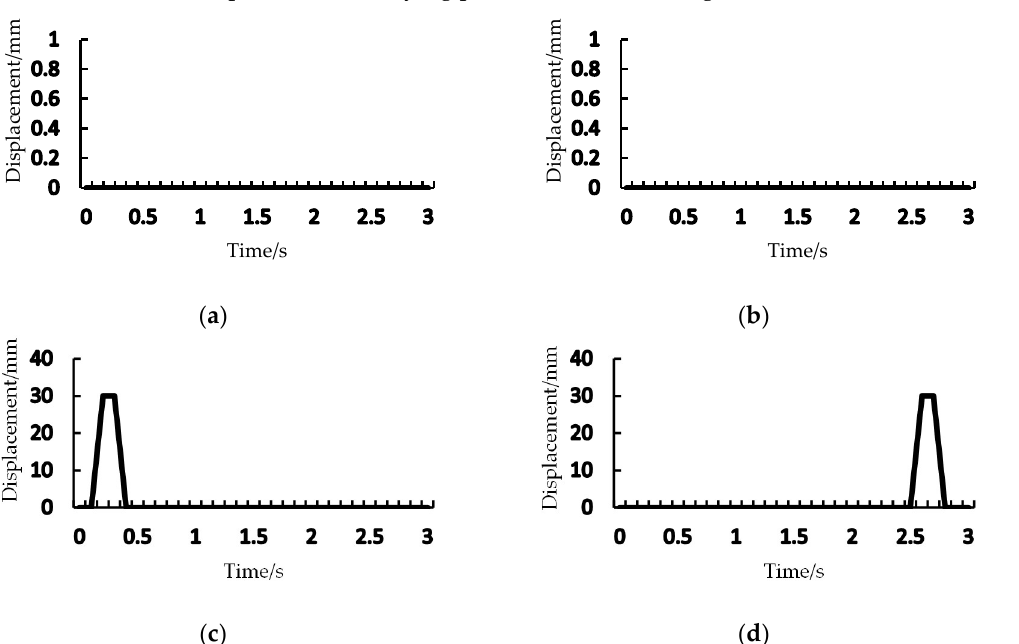
Figure 5. Loading method for displacement loads on tires. ( a ) is a loading mode of the left front wheel; ( b ) is a loading mode of the left rear wheel; ( c ) is a loading mode of the right front wheel; ( d ) is a loading mode of the right rear